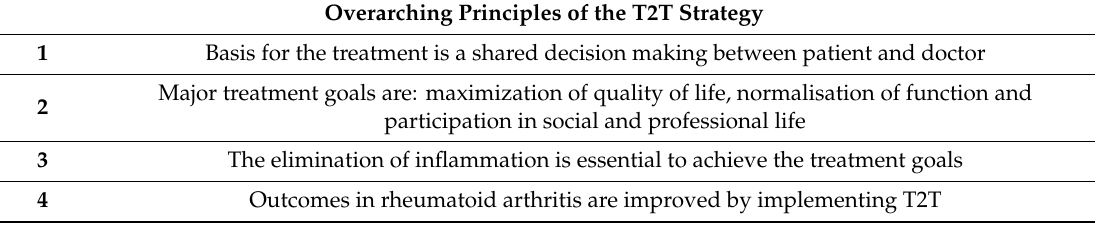
Table 1. Overarching principles of the T2T strategy (modified after Smolen J.S., et al. Ann Rheum Dis 2016;75:3–15).